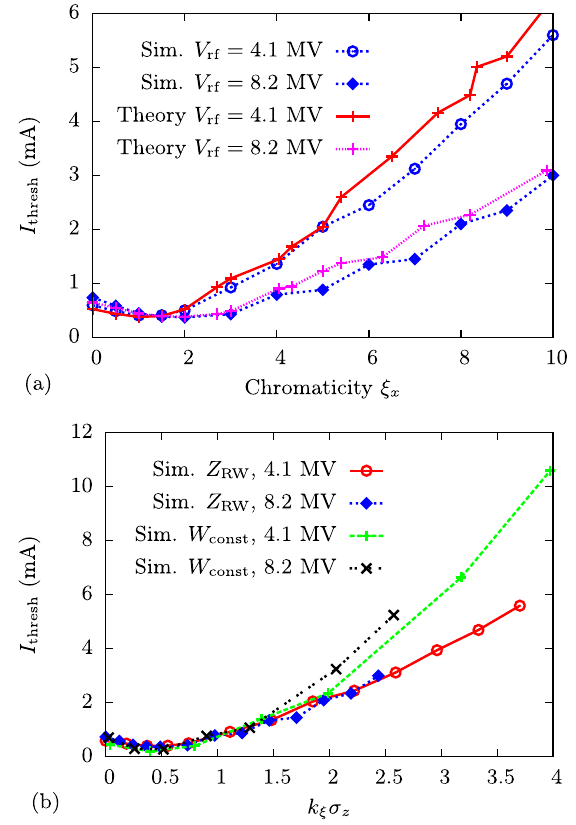
FIG. 3. (a) Maximum stable current I as a function of thresh chromaticity for two different rf voltages. As the chromatic head- tail shift becomes larger than unity the current threshold is higher for the lower rf voltage that has a longer bunch length. (b) shows that the I is approximately a function of k ξ σ for both the z thresh resistive wall impedance Z and the constant wake W RW